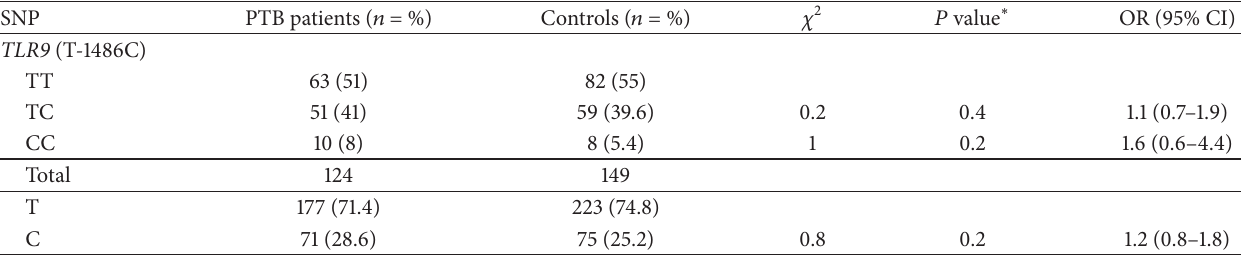
Table 4: TLR9 -1486T/C genotype and allele frequencies in patients and